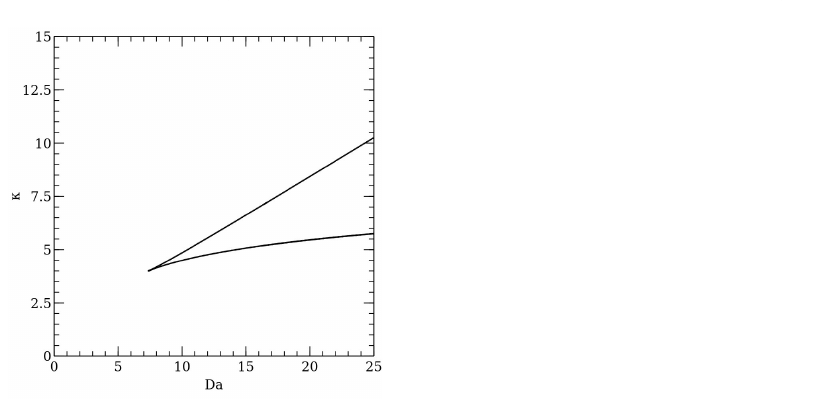
Figure 3. The catastrophic plot—the two-parametric relation. For parameters values between the curve, triple steady states occur. Otherwise, singular steady states take place.